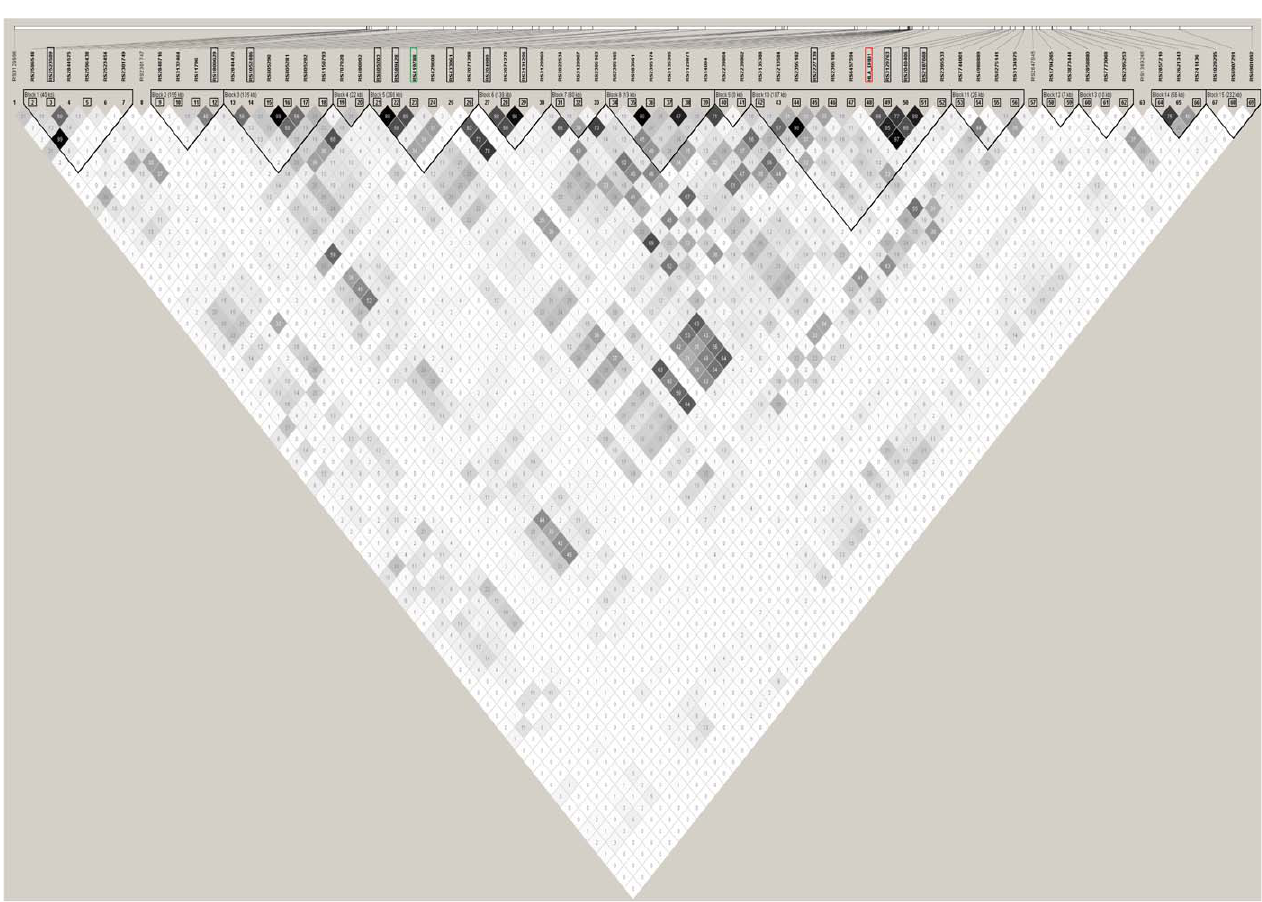
Figure 1. LD Plot of All 69 MHC Markers Typed in 314 UK SLE Trios The figure illustrates the correlation between all 69 MHC markers successfully typed across 2.4 Mb of genome encompassing MHC class II and class III in 314 UK SLE trios. The markers are identified by rs numbers for the 68 SNPs while HLA_DRB1 indicates all HLA-DRB1 alleles coded as a biallelic marker: HLA-DRB1*0301 /non- HLA-DRB1*0301 . The numbers shown below the marker names correspond to the marker numbering in Tables 1, S1, and S3 for ease of interpretation. The grey ticks indicate SNP location to scale. The triangular units designate haplotype blocks. The open rectangles represent the 14 markers that show significant association in the cohort after permutation testing; the green rectangle highlights our class III signal, SNP rs419788 ; and the red rectangle designates our class II signal, HLA-DRB1 . The 53 markers used for the EHH analyses and haplotype bifurcation plots are designated by open squares. The degree of correlation between pairs of markers is indicated by the correlation coefficient r 2 (where r 2 ¼ 0 ¼ no correlation, white; 0 , r 2 , 1, shades of grey; r 2 ¼ 1 ¼ complete correlation,